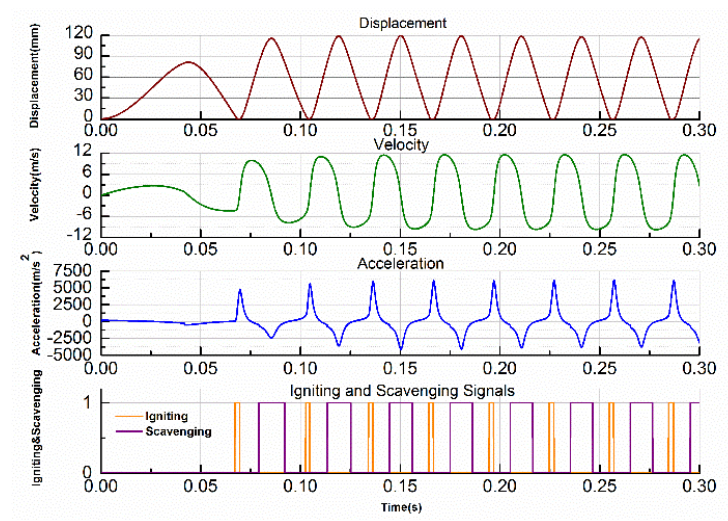
Figure 14. Simulated dynamic responses (Displacement, velocity, acceleration, igniting and scavenging signals).